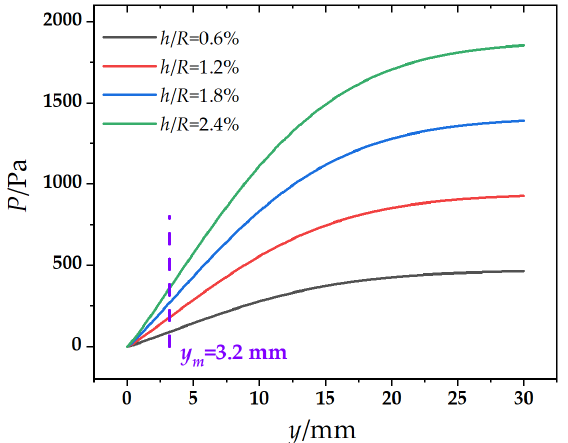
Energies 2022 , 15 , x FOR PEER REVIEW 10 of 14 Figure 12. Relation between pressure and particle diameter under four different h / R .